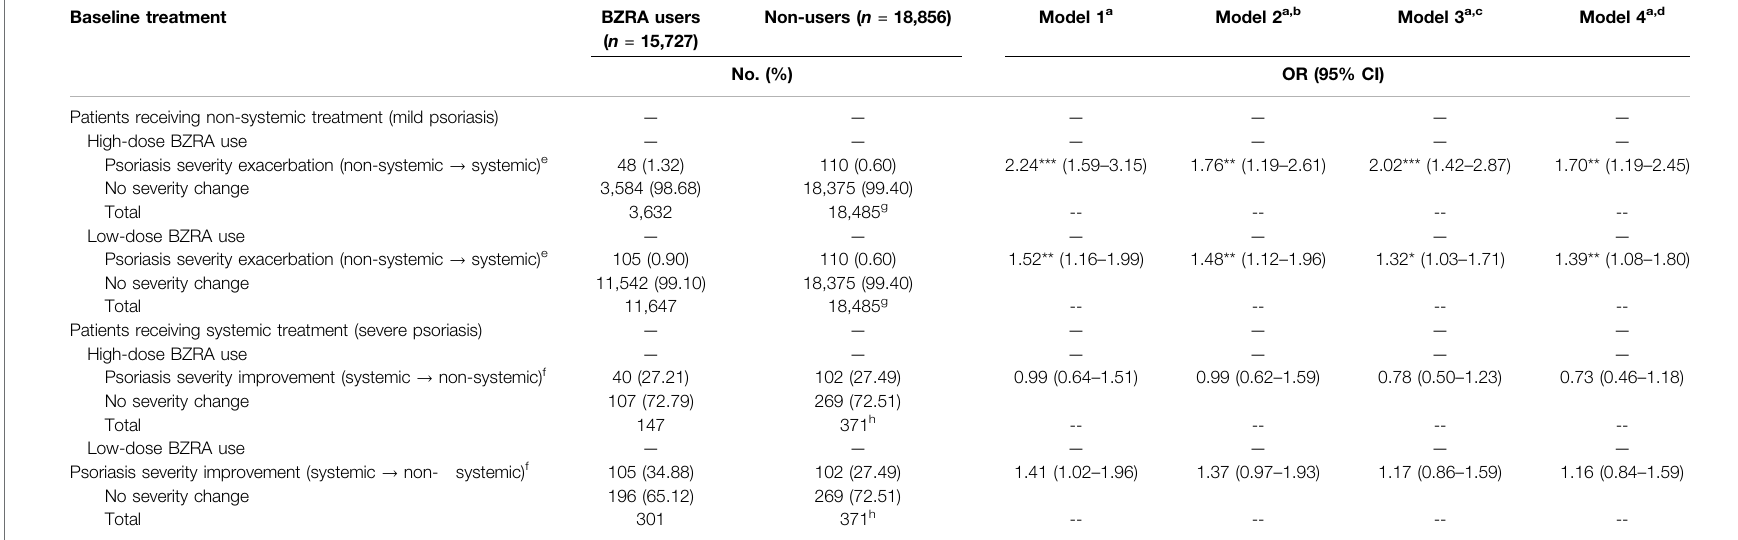
Notes: BZRA, benzodiazepine receptor agonist; OR, odds ratio; CI, con fi dence interval. a Logistic regression was used to evaluate the ORs and 95% CIs. b Adjusted for patients ’ demographics and comorbidities. c Weighted using the inverse probability of treatment weights (IPTW). d Weighted using IPTW and adjusted for patients ’ demographics and comorbidities. e Exacerbate the severity of psoriasis. f Improve the severity of psoriasis. g Same